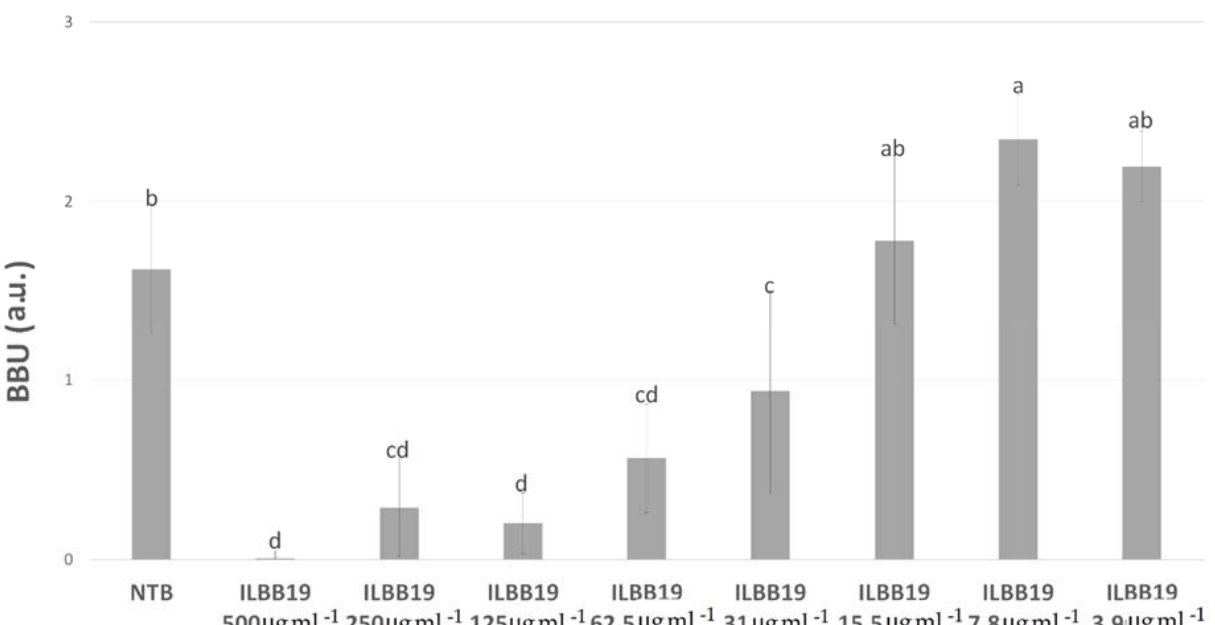
Figure 3. Inhibition of Staphylococcus aureus biofilm by different concentrations of ILBB19 extract. Different letters (a, b, c, d) represent significant differences ( p < 0.05)